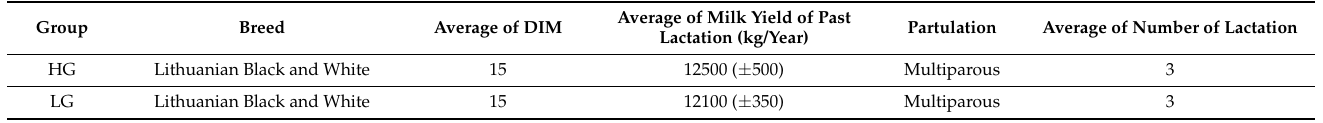
Table 1. Characteristics of experimental